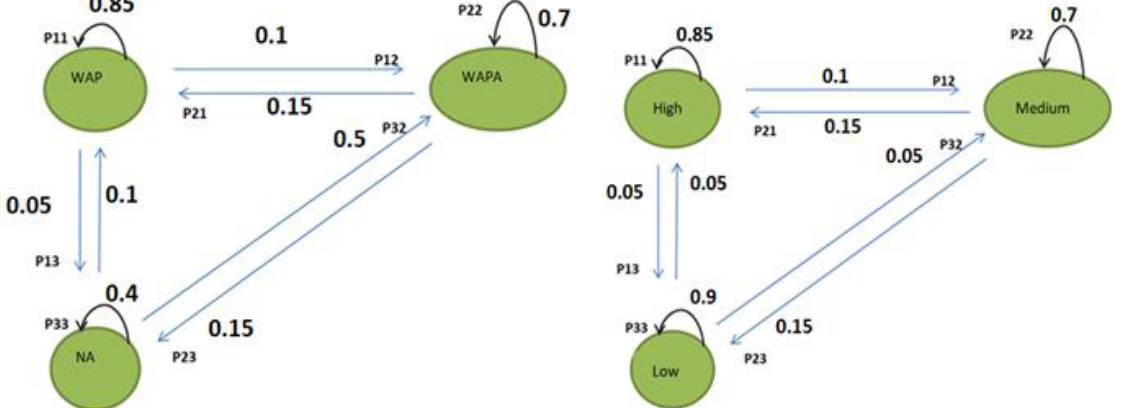
Figure 14. Transition for WAP, WAPA, and NA and High, Medium, and Low.